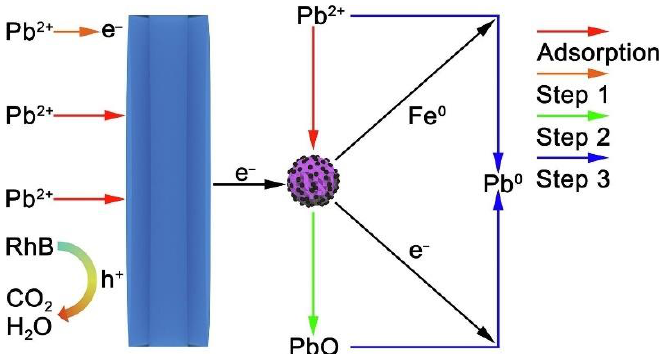
Figure 6. Schematic illustration of the simultaneous elimination mechanism in 1FeCTi [59]. Copyright, 2019 Elsevier Inc.